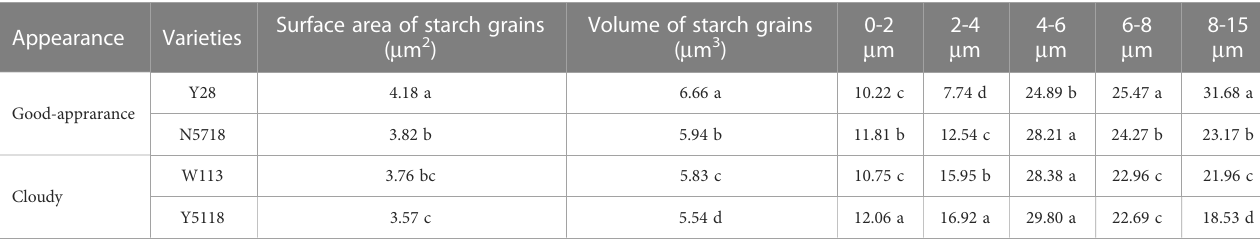
TABLE 3 Starch grain size distribution of the four soft rice varieties.